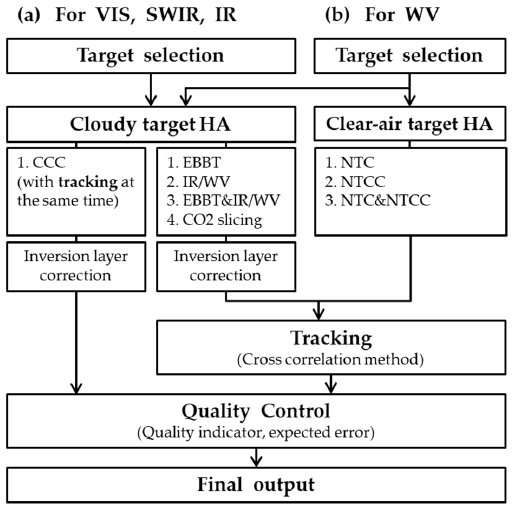
Figure 2. Flowchart of the GEO-KOMPSAT-2A atmospheric motion vector (GK-2A AMV) retrieval